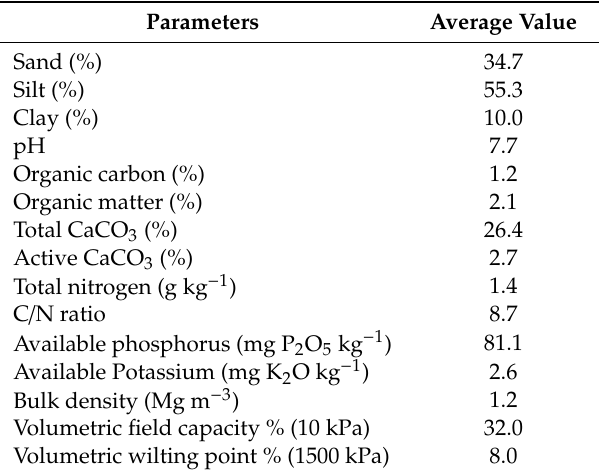
Table 1. Main features of soil used during the